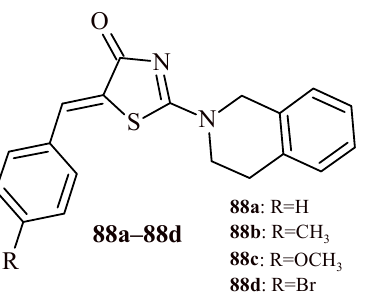
Figure 37. The structures of rhodanine-based tetrahydroisoquinoline derivatives. Szabo et al. evaluated inhibitory activity of rhodanine derivatives ( 89a – 89f and 90 ) towards porcine pancreatic α -amylase (PPA) and α -glucosidase (Figure 38). These rhodanine derivatives previously were reported as inhibitors of human aldose reductase (AR) and PTP1B [90]. Each of the tested compounds ( 89a – 89f and 90 ) showed inhibitory potential against human AR at submicromolar/nanomolar concentration (IC 50 = 0.052–0.228 µM). On the other hand, only Compounds 89e , 89f and 90 showed considerable inhibitory effects towards human PTP1B at concentration <100 µM. The Compounds 89a – 89f and 90 possessed diverse inhibitory potential in the tests towards α -amylase and α -glucosidase. Some of them exhibited appreciable effects at concentration ≤ 100 µM (Compounds 89b – 89d ), others moderate or insignificant activities (Compounds 89a , 89e , 89f and 90 ). As further step of the study, it was evaluated whether inhibitory effects of Compounds 89a – 89f and 90 might be due to specific interactions with multiple targets or to non-specific inhibition based on aggregation. Among the tested rhodanines Compounds 89b , 89e , 89f and 90 showed aggregation-based mechanism of action. Whereas Derivatives 89a , 89c , 89d act as multi-target inhibitors without aggregates formation [91].